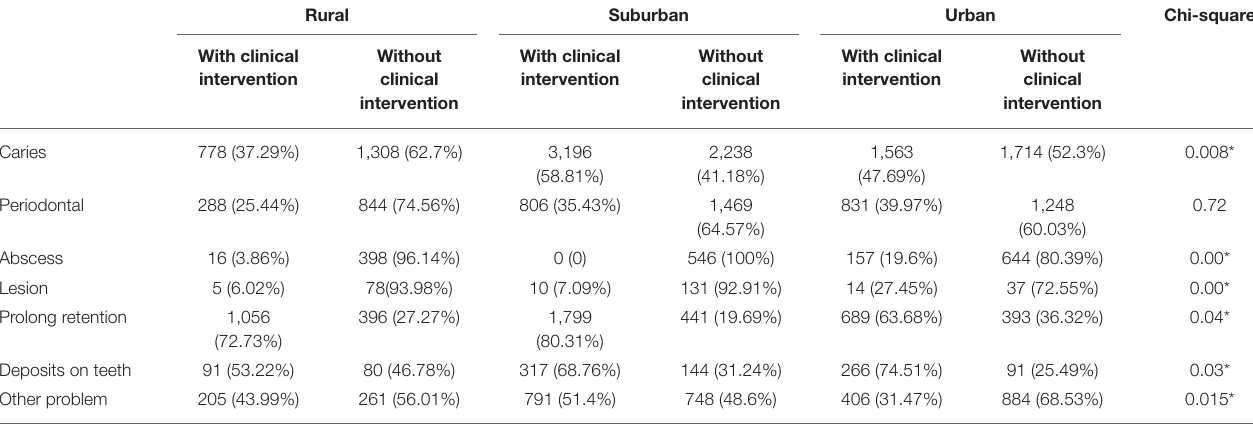
TABLE 1 | Characteristics of the clinical intervention pattern in percentage.